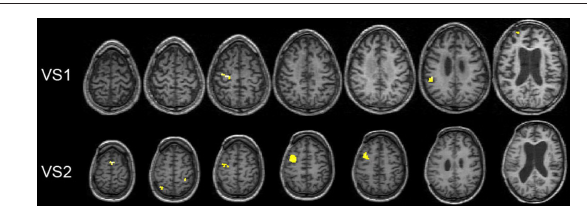
Figure 4 | Functional results from whole-brain fixed-effect univariate analysis. Activation for patients VS1 and VS2 when comparing right vs. left-hand commands. All BOLD activity maps are superimposed on each individual’s structural image. Statistical threshold level is set at p < 0.003 for illustrative purposes.